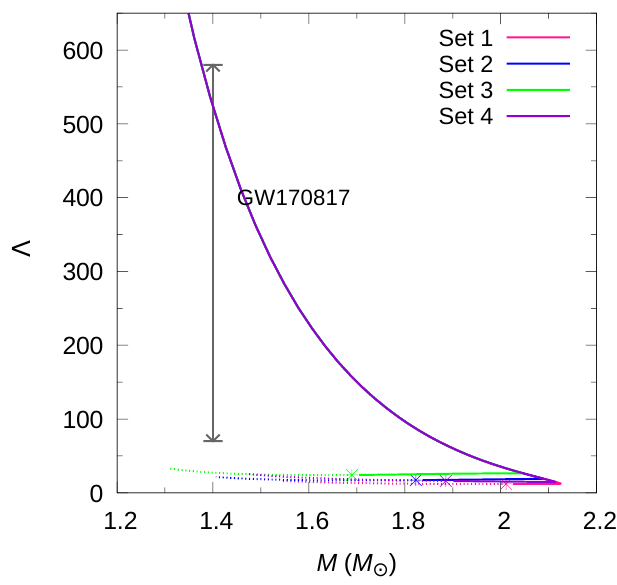
Figure 7. (Color online) Dimensionless tidal deformability as a function of gravitational mass, with the constraint obtained from GW170817 [5]. Stable stellar configurations beyond the maximum mass have very small values of Λ , which are almost independent of mass. The positions of the terminal stars of the twin HSs branch (obtained for slow hadron-quark conversion) are marked with